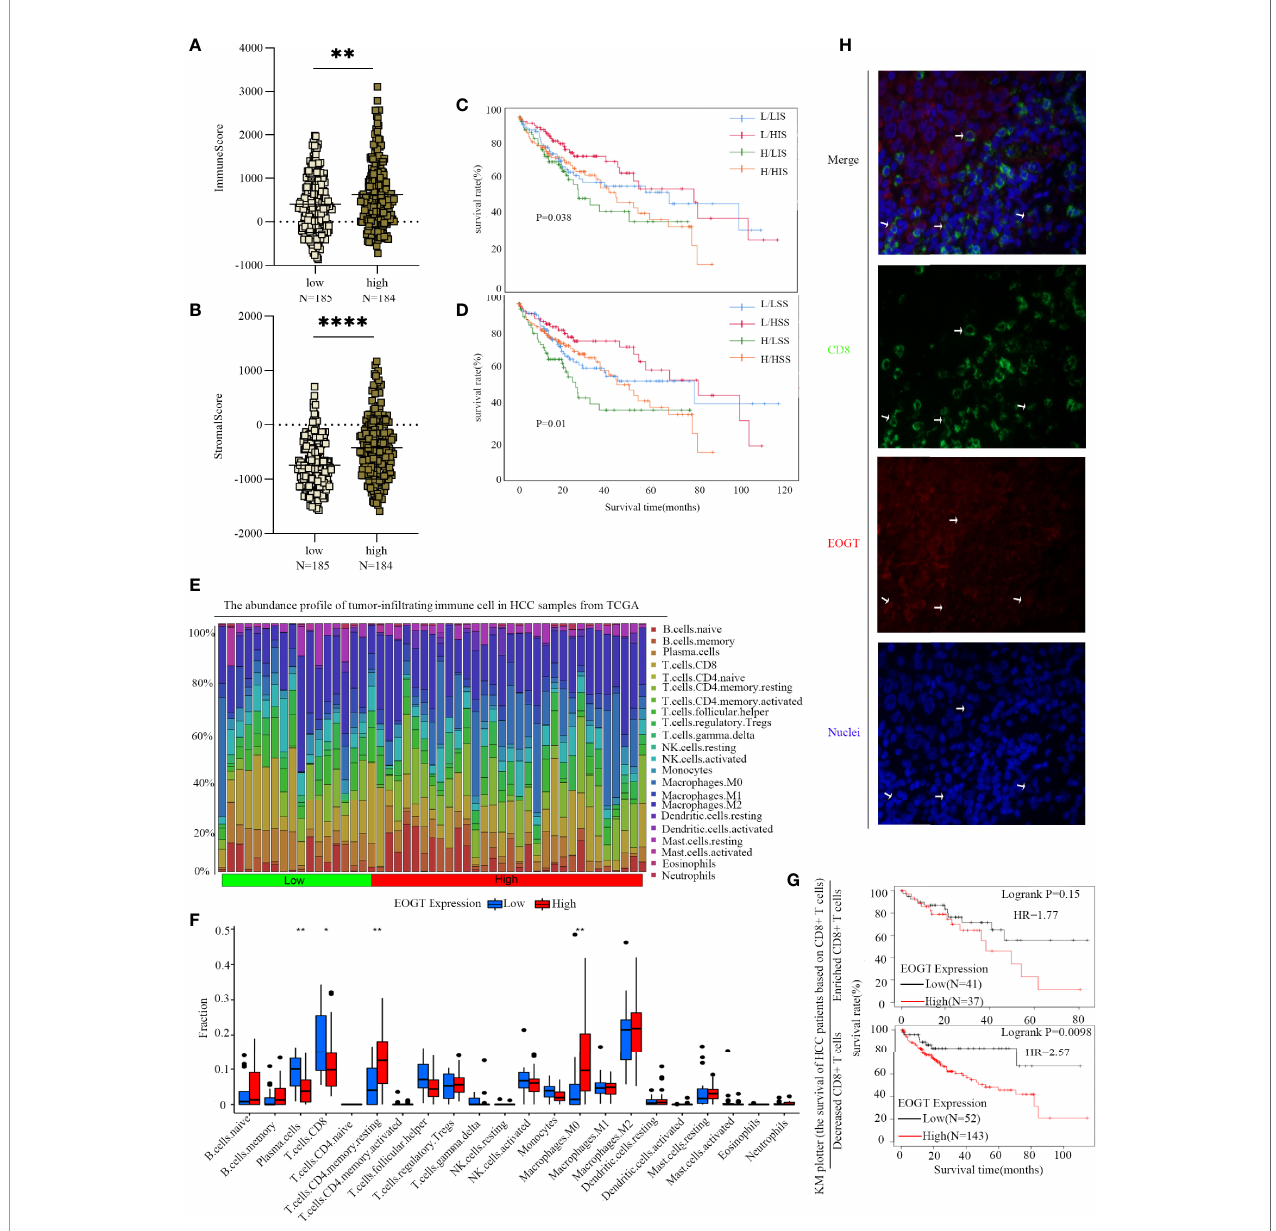
FIGURE 9 | Differences of immune scores (A) and stromal scores (B) between EOGT-low and EOGT-high expression subgroups. (C, D) KM survival curve of OS based on immune scores, stromal scores, and EOGT expression levels. L and H, respectively, represented the low-EOGT and high-EOGT expression groups. LIS and HIS, respectively, represented low-immune scores group and high-immune scores group. LSS and HSS, respectively, represented low-stromal scores group and high-stromal scores group. (E) Twenty-two tumor-in fi ltrating immune cells in HCC samples were estimated using the CIBERSORT algorithm. (F) The proportion of 22 tumor-in fi ltrating immune cells in HCC samples with high- and low-EOGT expression. (G) KM curves of OS in HCC samples based on EOGT expression and the levels of tumor-in fi ltrating CD8 + T cells. (H) Immuno fl uorescent staining of EOGT (red), CD8 (green), and DAPI (blue) in HCC tissues (* P < 0.05, ** P < 0.01, **** P <